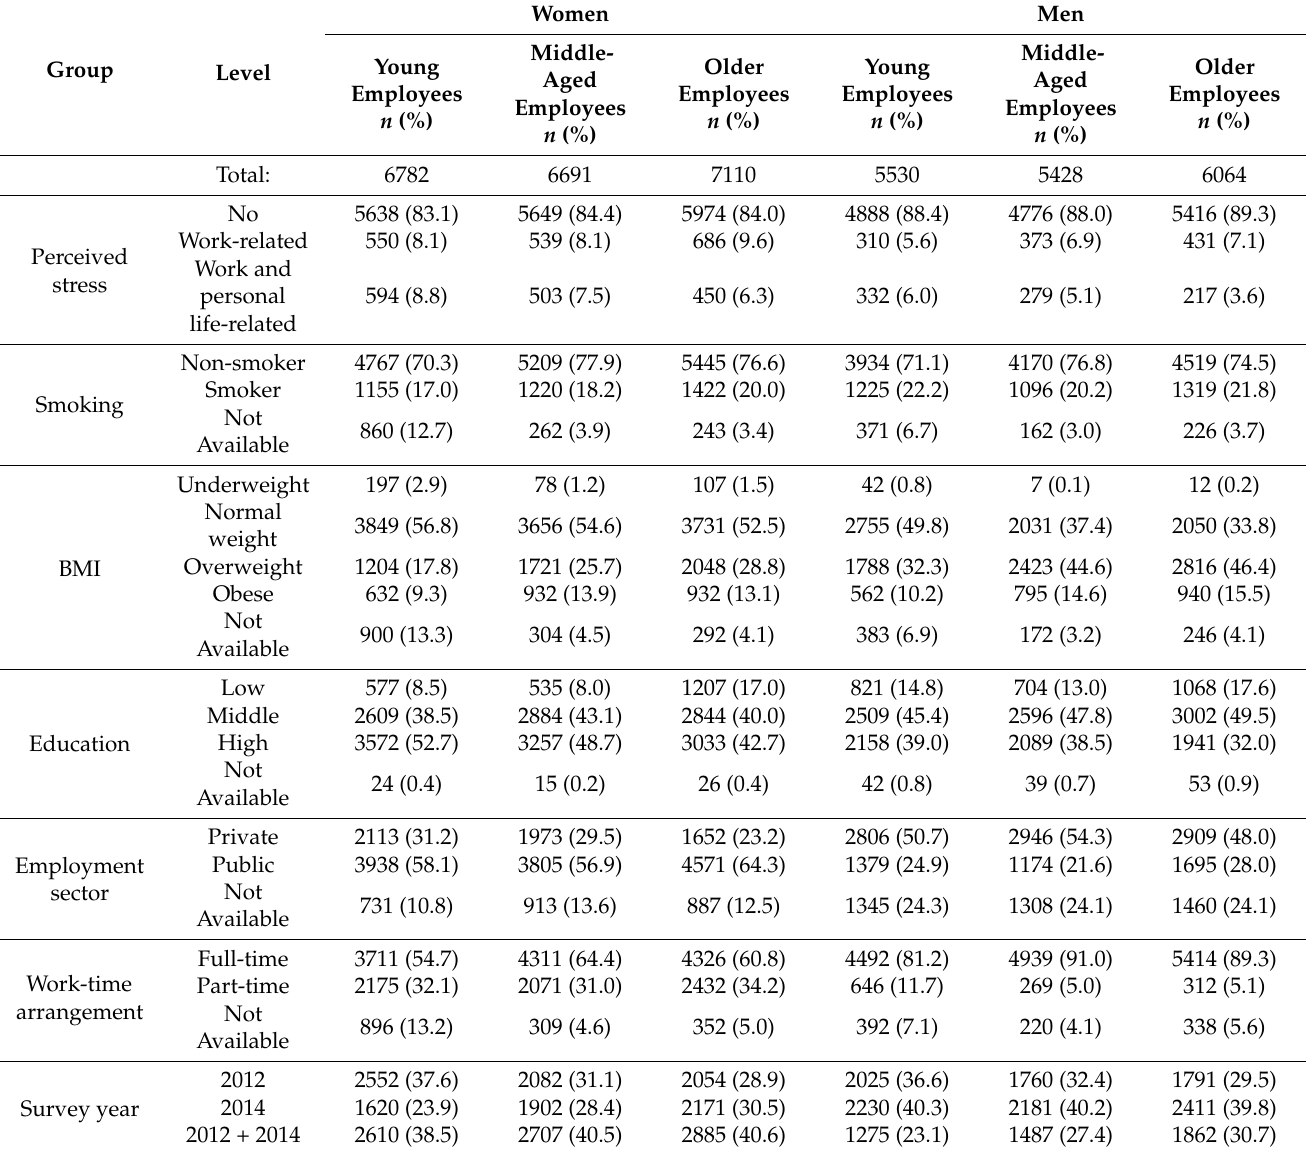
Table 1. Descriptive characteristics of the study population ( n =